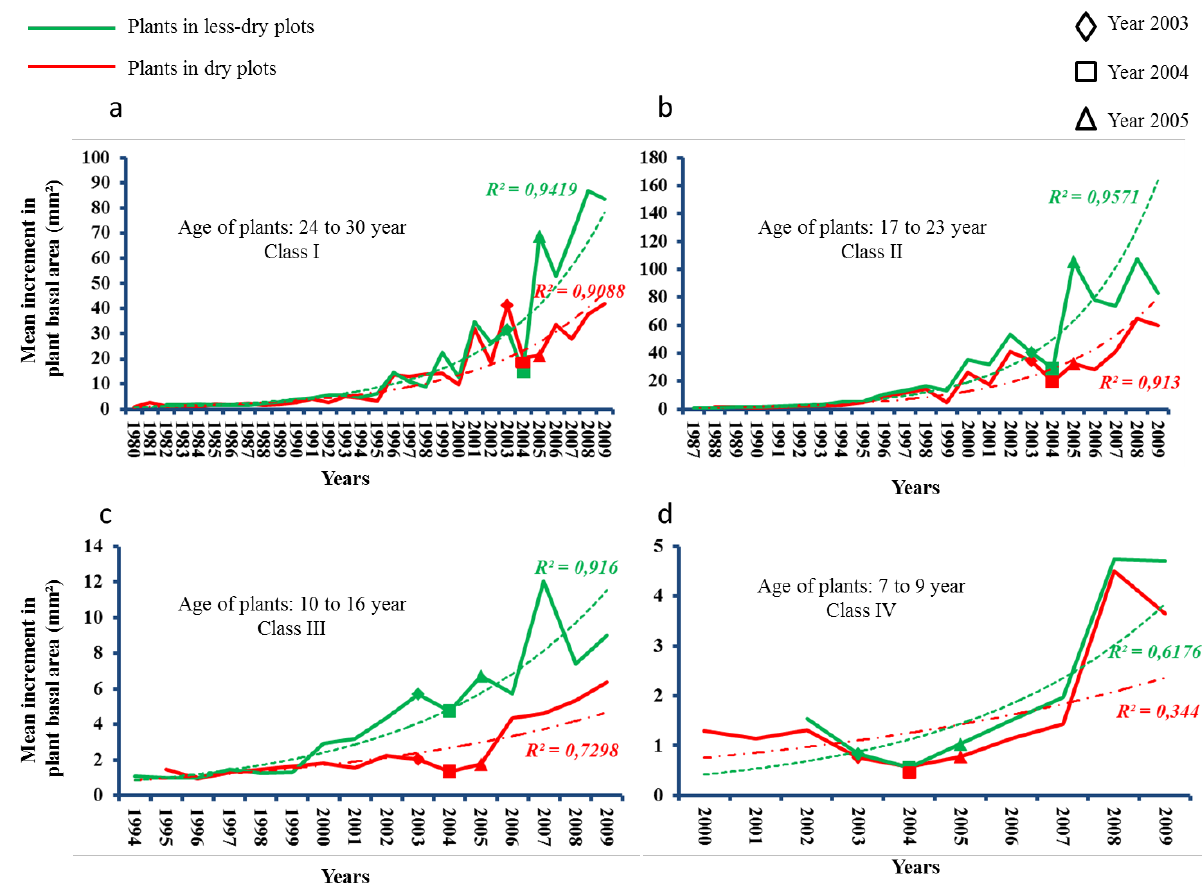
Figure 6. Trends in basal area increments in 42 beech plants in four different age classes (Class I = 24 to 30 year old, ( a ); Class II = 17 to 23 year old, ( b ); Class III = 10 to 16 year old, ( c ); and Class IV = 7 to 9 year old ( d ). The summer drought of 2003 was used as pointer year. Non-linear regression (after post hoc testing) with power function was used to report the strength in the growth